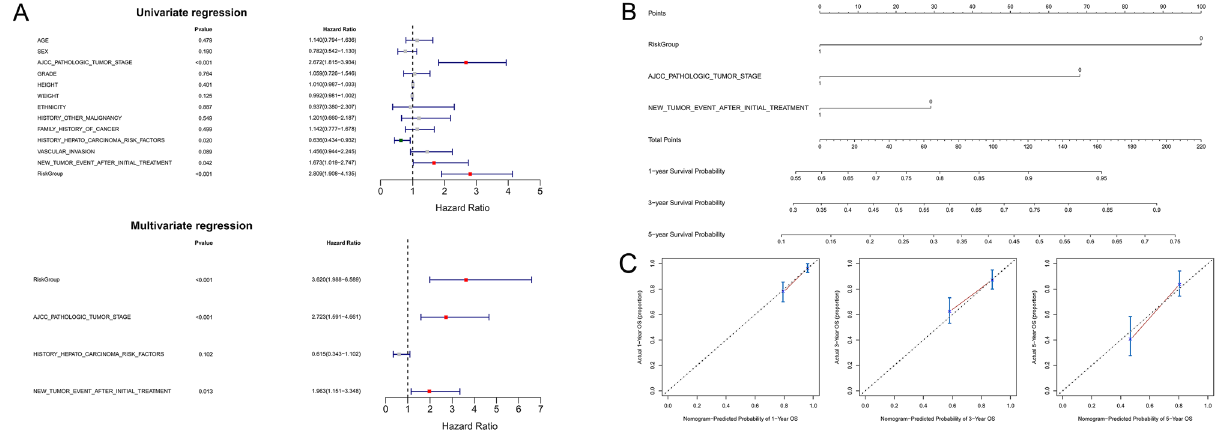
Figure 7. Univariate and multivariate Cox analysis of the signature combined clinical features and construction of the nomogram. ( A ) Forest characteristics of clinical features and risk score using univariate and multivariate Cox analysis. ( B ) Construction of the nomogram. For each patient, three lines are drawn upward to determine the points received from the three predictors (RiskGroup, AJCC_PATHOLOGIC_TUMOR_STAGE, and NEW_ TUMOR_EVENT_AFTER_INITIAL_TREATMENT) in the nomogram. The nomogram is applied by adding up the points identified on the points scale for each variable to a total points amount. The sum of these points is located on the ‘Total Points’ axis. Finally, beneath the total points, the probability of 1-, 3-, 5-year overall survival is projected on the bottom scales. ( C ) The calibration plot for validation of the nomogram. The Y-axis represents actual survival, and the X-axis represents nomogram-predicted